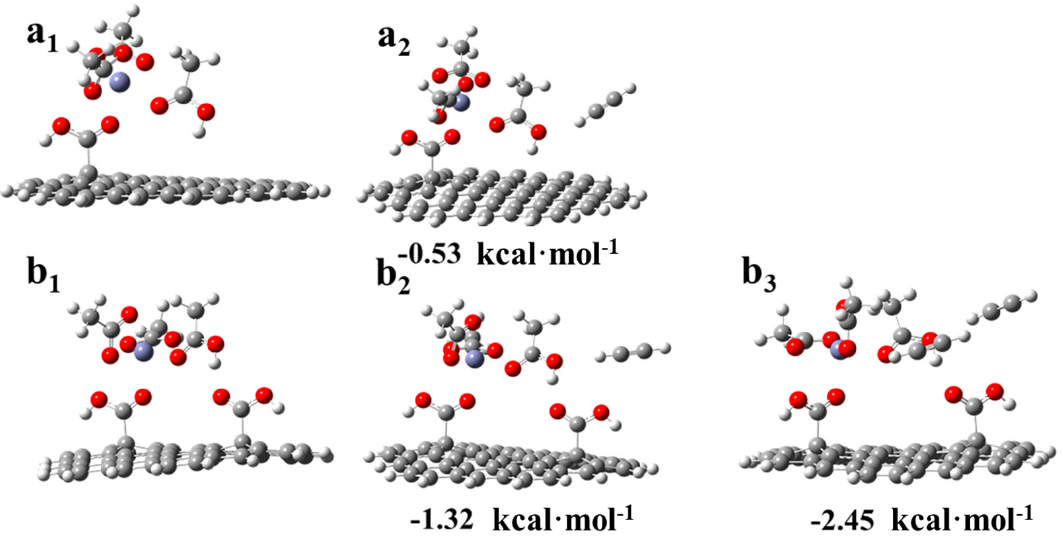
Figure 9. DFT results of the adsorption of acetylene during the reaction: ( a 1 ) acetic acid adsorbed on the reaction site of the monocarboxylic catalytic system. ( a 2 ) Adsorption of acetylene during the reaction in the monocarboxylic catalytic system. ( b 1 ) Acetic acid adsorbed on the reaction site of the dicarboxylic catalytic system. ( b 2 ) Adsorption of the first acetylene molecule during the reaction in the dicarboxylic catalytic system. ( b 3 ) Adsorption of the second acetylene molecule during the reaction in the dicarboxylic catalytic system.